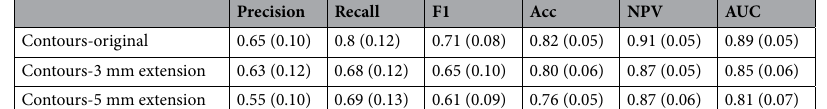
Precision Recall F1 Acc NPV AUC Contours-original